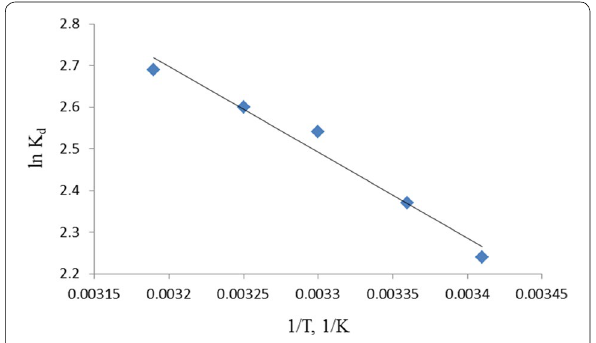
Fig. 11 Plot of ln Kd versus 1/T for removal of MG by